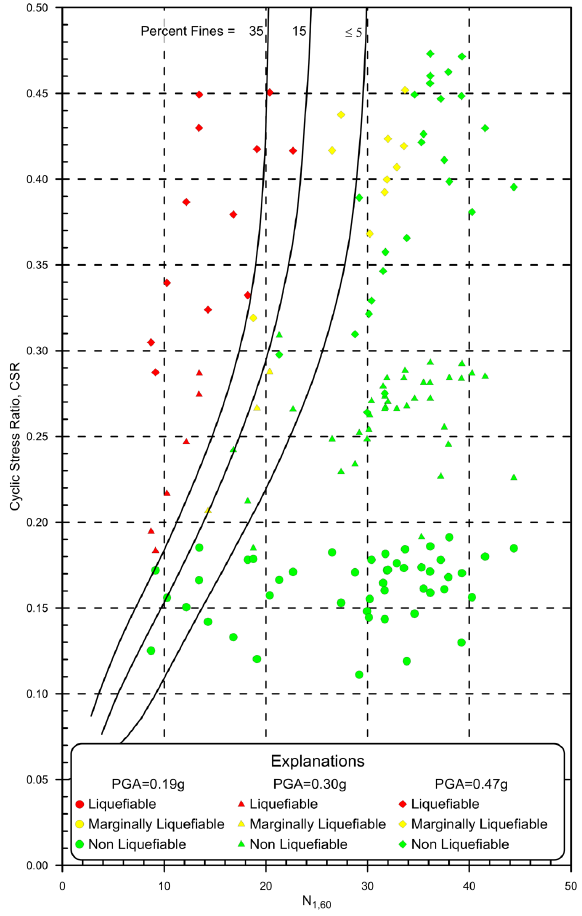
Fig. 15. Cyclic stress ratio and SPT N 1 , 60 plot based on Youd et al. (2001).